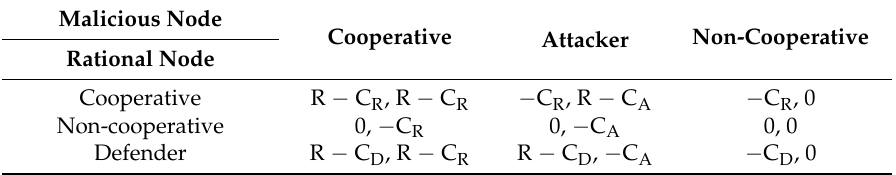
Table 2. Profit matrix for active defensive